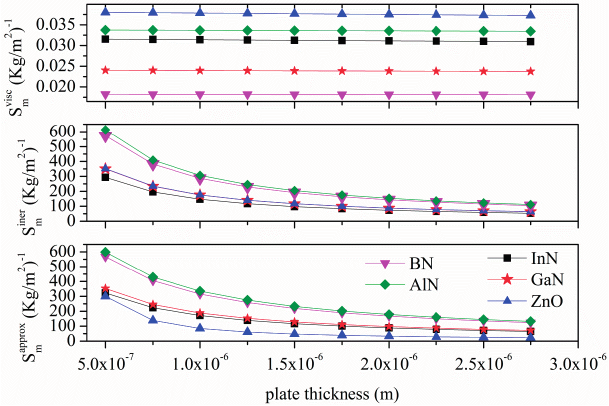
Figure 14. S 0 mode relative velocity changes, Δ v/v in and Δ v/v visc , due to the inertial and viscous effects of the water contacting the plate, vs. the plate thickness.